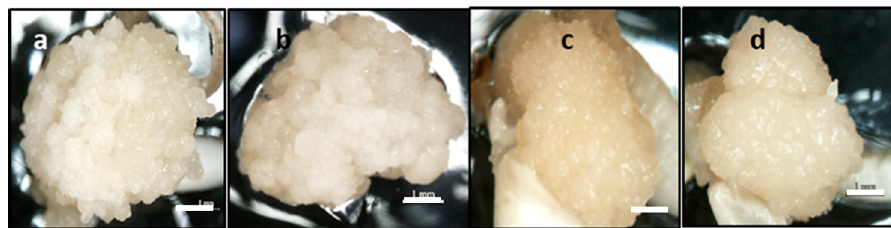
Figure 4. The morphology of calli ( a , c ) MR220 and ( b , d ) MR220-CL2. ( a , b ): Embryogenic calli with compact structure from MS media added with 30 g/L of maltose and 3 mg/L of 2, 4-D; ( c , d ): Non-embryogenic with friable and loosely held cell from MS media with 30 g/L of maltose and 1 mg/L 2, 4-D (Bar = 1 mm).